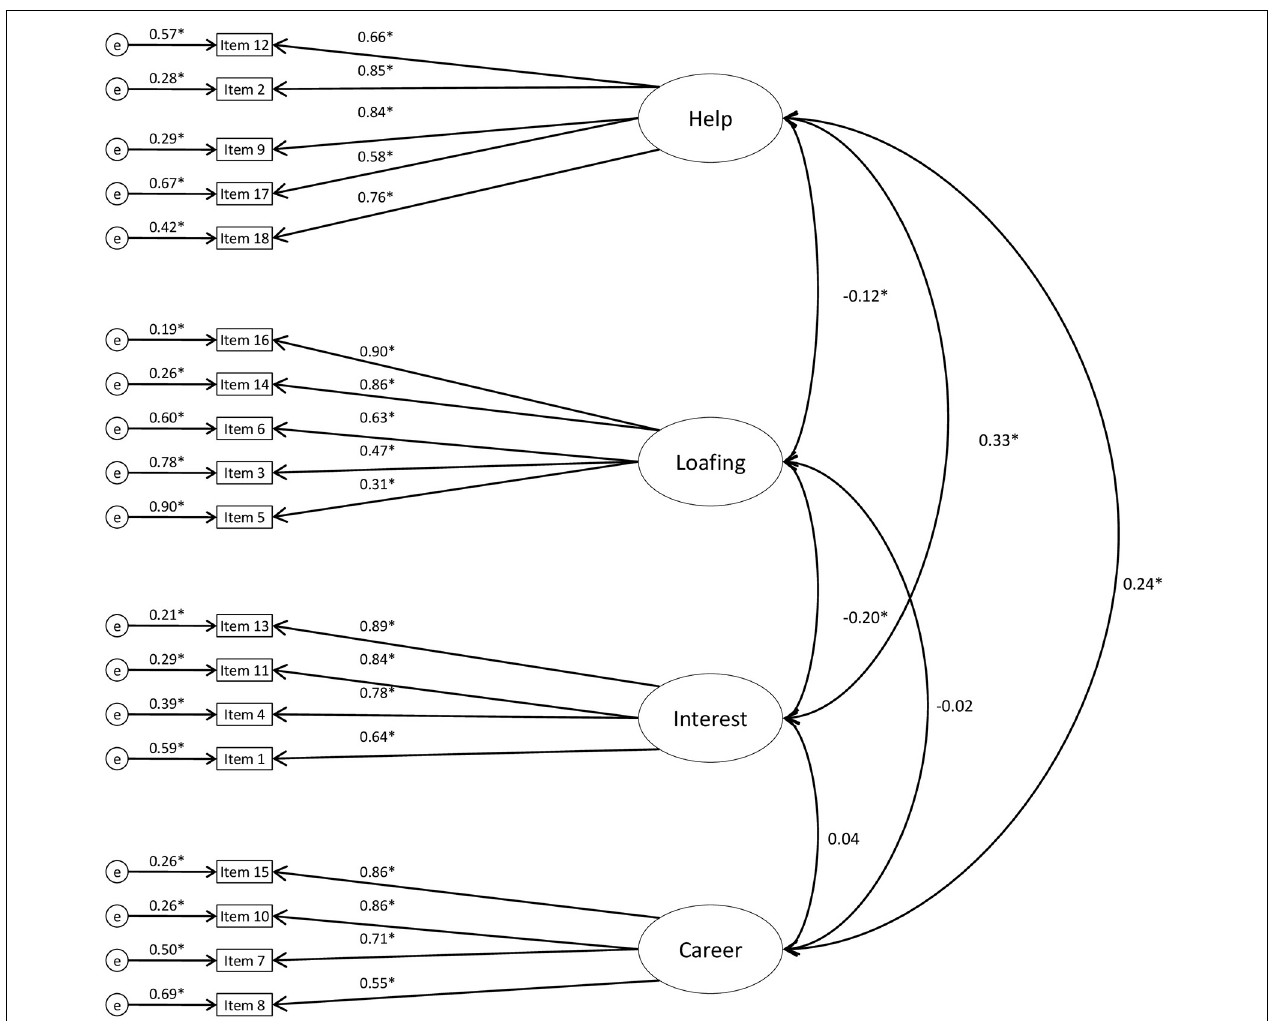
FIGURE 1 | CFA model with standardized estimates: MICC, Sample 1 ( N =